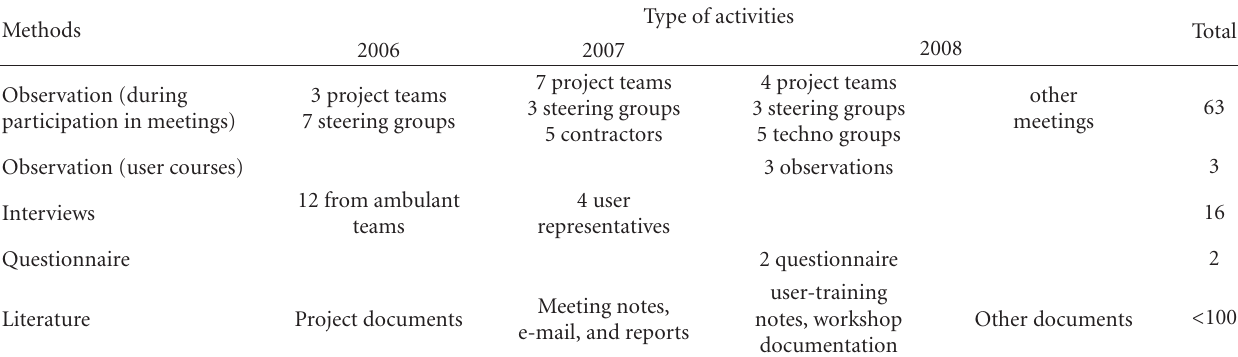
Table 2: Data collections methods